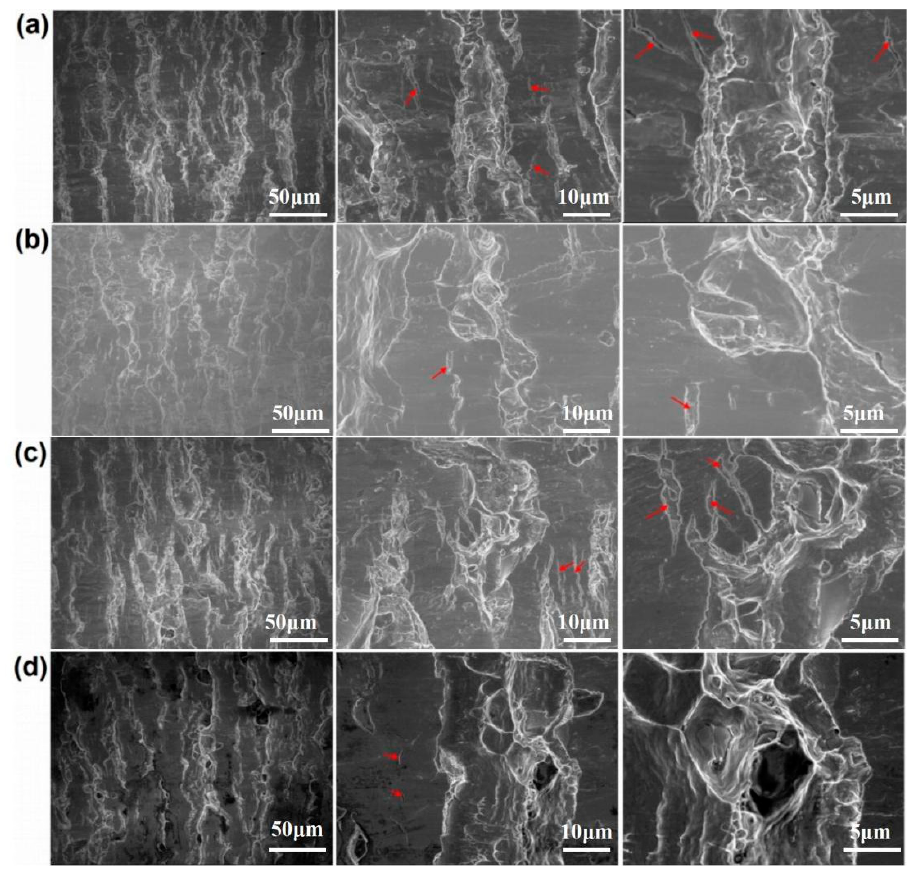
Figure 7. Peeling surface morphology on the titanium side. ( a ) Specimen B2; ( b ) specimen B3; ( c ) specimen C2; ( d ) specimen C3. The red arrows indicates cracks on the peeling surfaces.